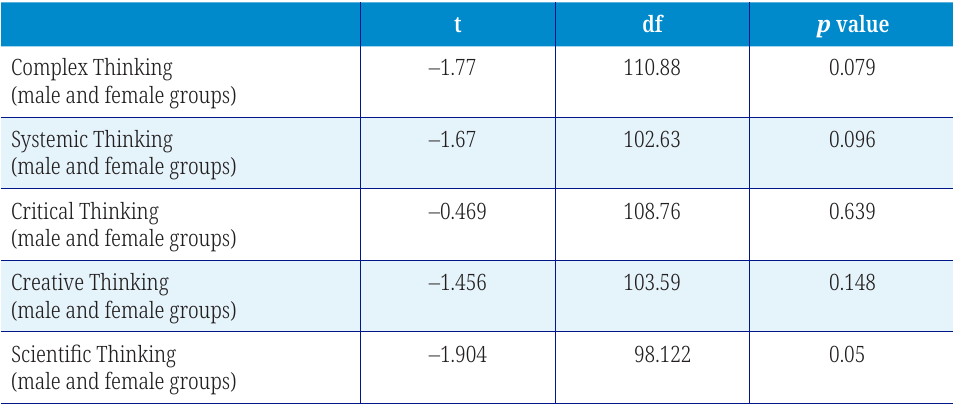
Table 5. Results of the significant differences between the male and female groups in the perception of achievement of complex thinking competence (student’s